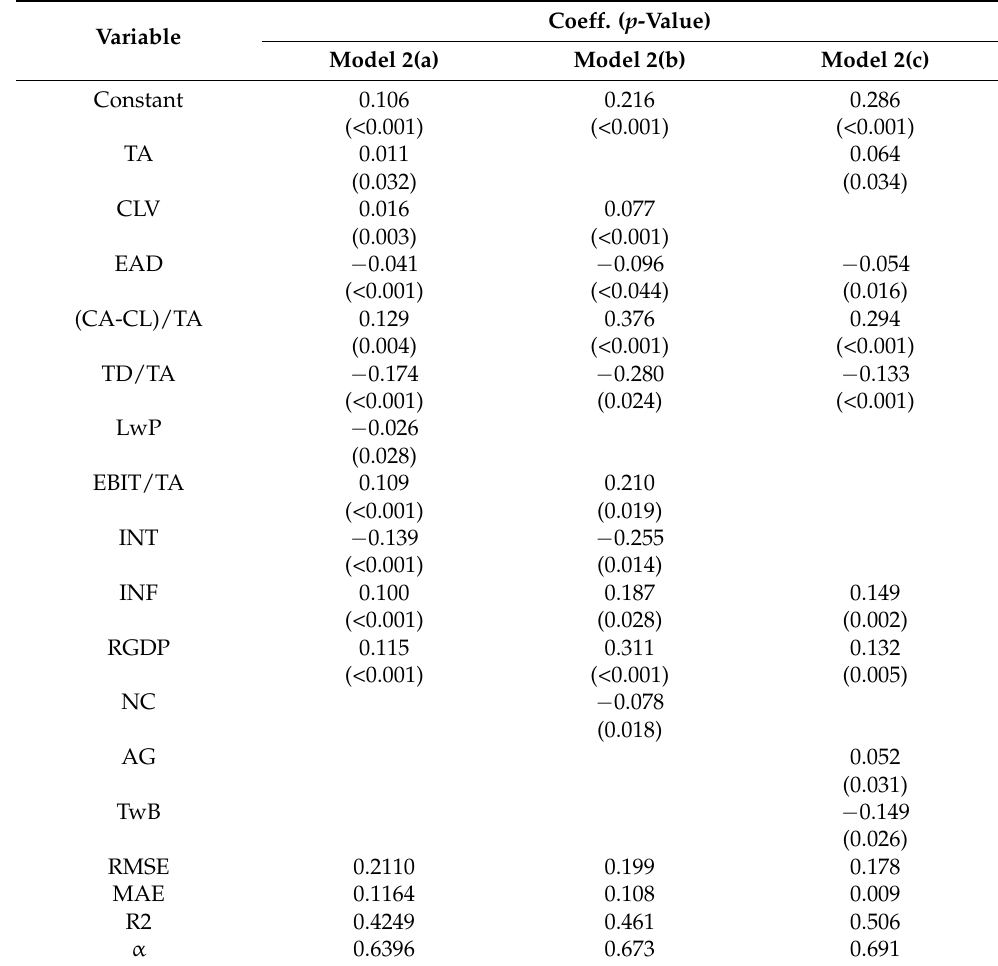
Table 4. Models premised on firm features, account characteristics and macroeconomic